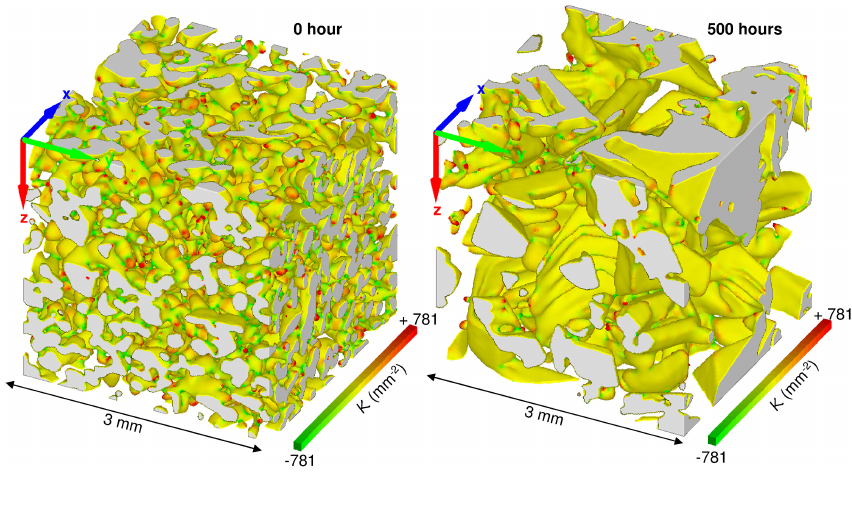
Figure 10. The initial (left panel) and final (right panel) 3-D images of the experiment where colors represent the Gaussian curvature of the surfaces, ranging from − 781 to + 781mm − 2 . Dome-shaped (concave or convex), flat or cylindrical and saddle-shaped surfaces are shown in red, yellow and green, respectively. Images have a size of 3mm × 3mm × 3mm. For a better visualization of the faceted shapes, the images are presented “upside down”. The arrows in blue, green and red correspond to the x , y and z directions of the images, respectively.